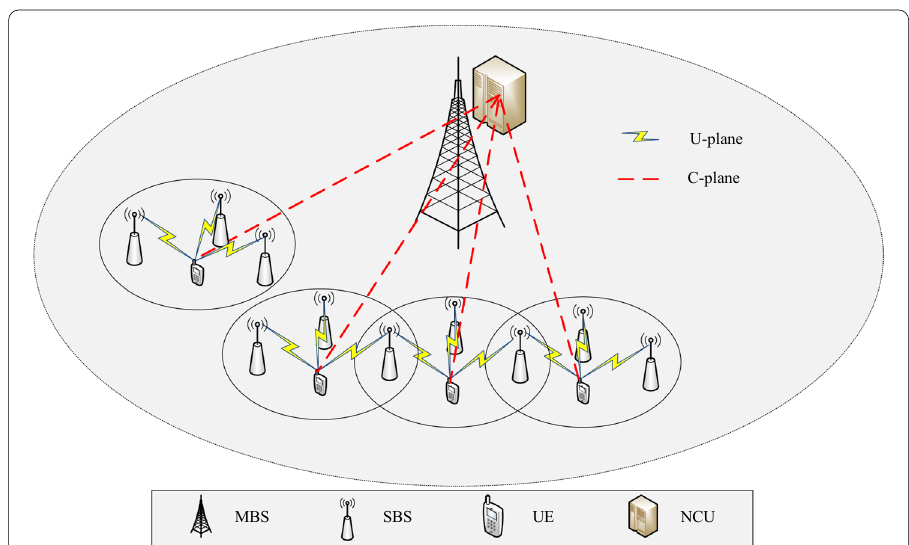
Fig. 1 The user-centric virtual cells system model of the ultra-dense